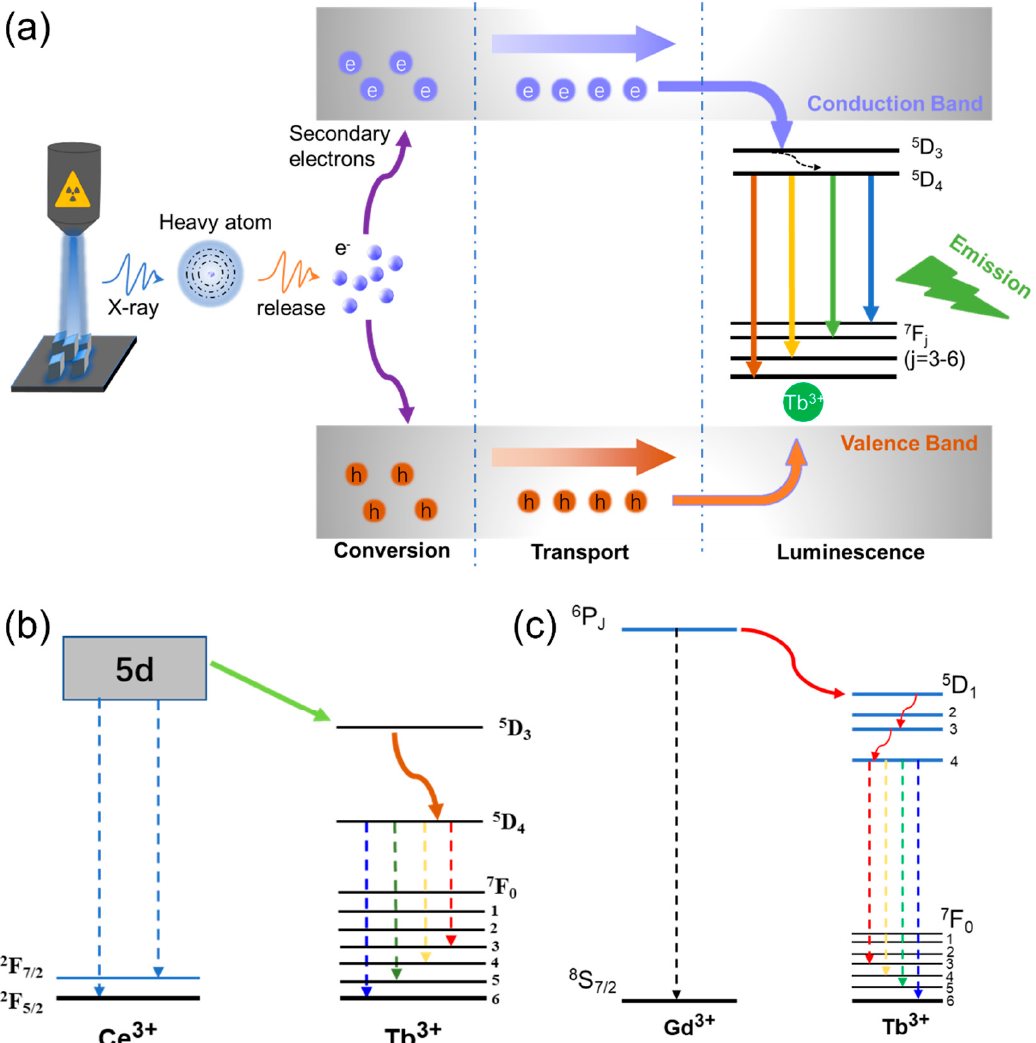
Figure 4. ( a ) Luminescence mechanism of the Pb 4 Lu 3 F 17 : Tb NCs upon X-ray irradiation. ( b ) Energy level transition diagram of Ce 3+ and Tb 3+ . ( c ) Energy level transition diagram of Gd 3+ and Tb 3+ .